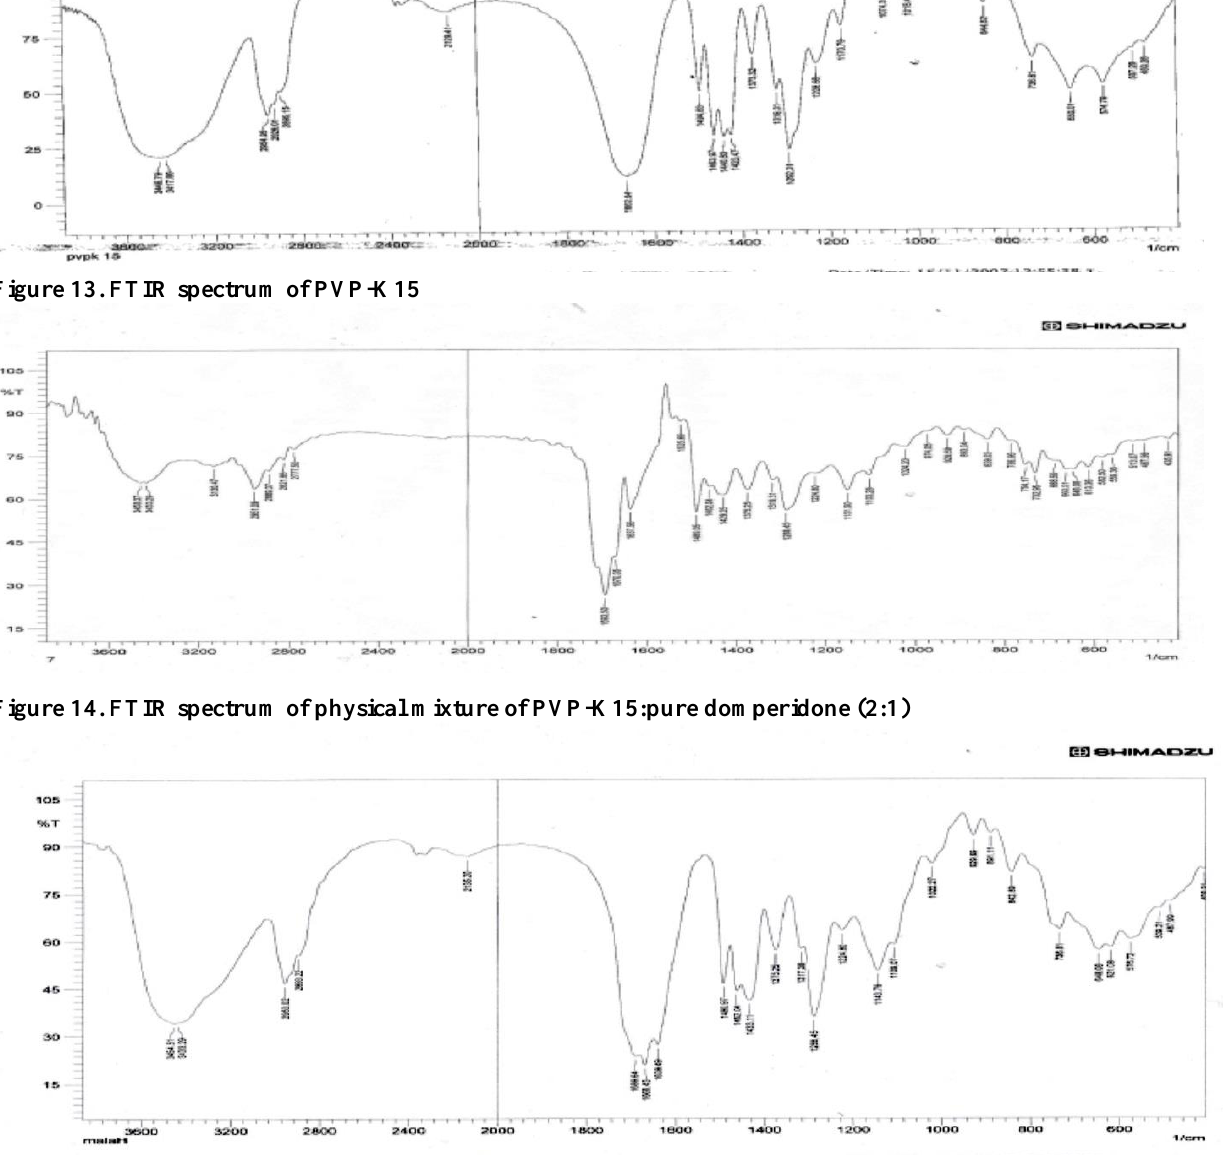
Figure 13. FTIR spectrum of PVP-K15